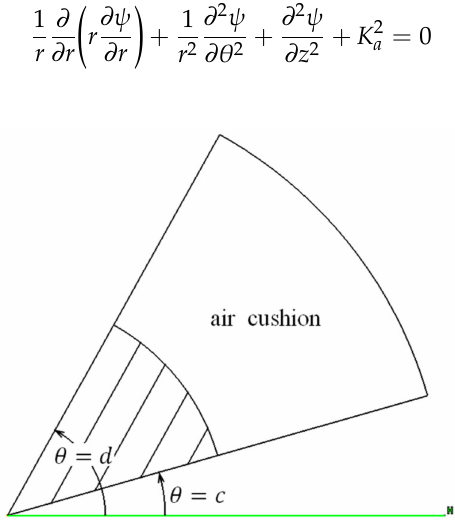
Figure 4. Top view of single fan-shaped air